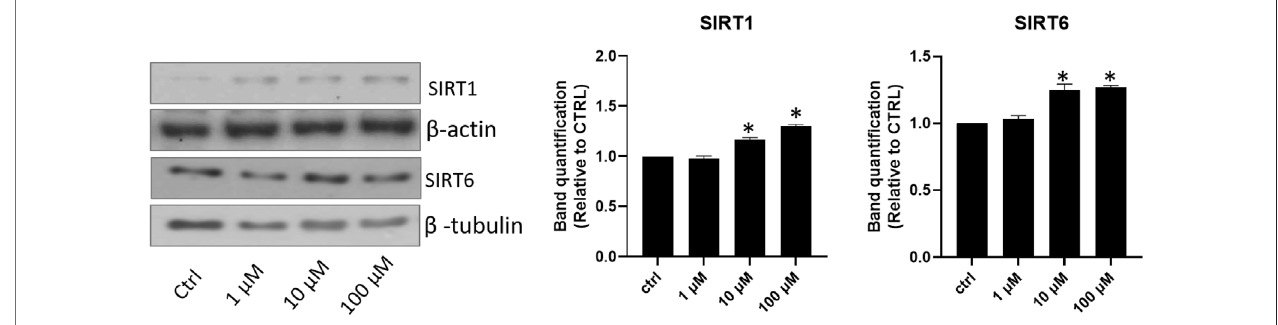
FIGURE3| EffectsoflisinopriltreatmentonSirtuin1andSirtuin6.WesternblotanalysisofSIRT1andSIRT6.Dataaremean±standarderrors.* p <